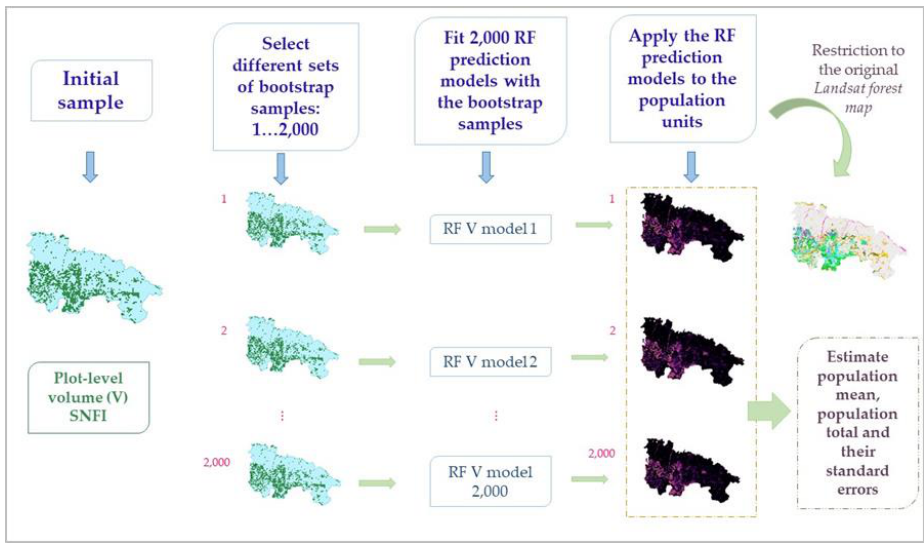
Figure 3. Wild bootstrapping scheme conducted in this study to account for the effects of plot-to-plot sampling variability in the model training data, ignoring uncertainty in the Landsat forest species map .